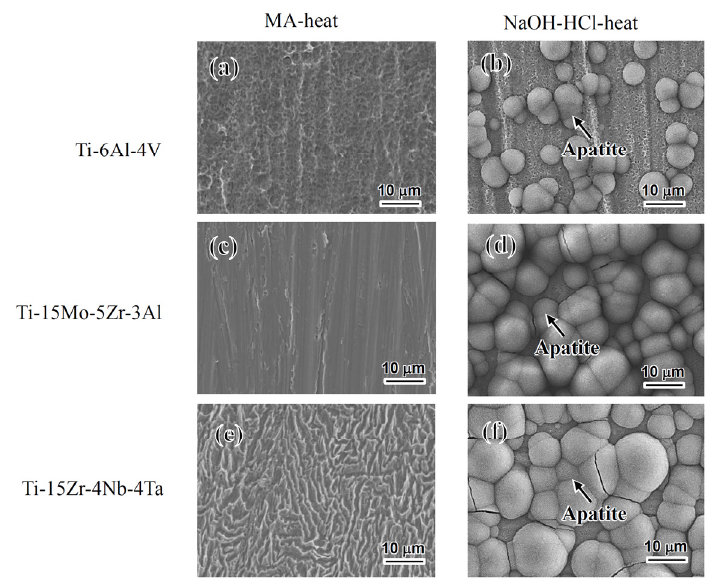
Figure 5. FE-SEM pictures of Ti alloys soaked in simulated body fluid (SBF) for 3 days following ( a ), ( c ), ( e ) MA-heat or ( b ), ( d ), ( f ) NaOH-HCl-heat treatment.